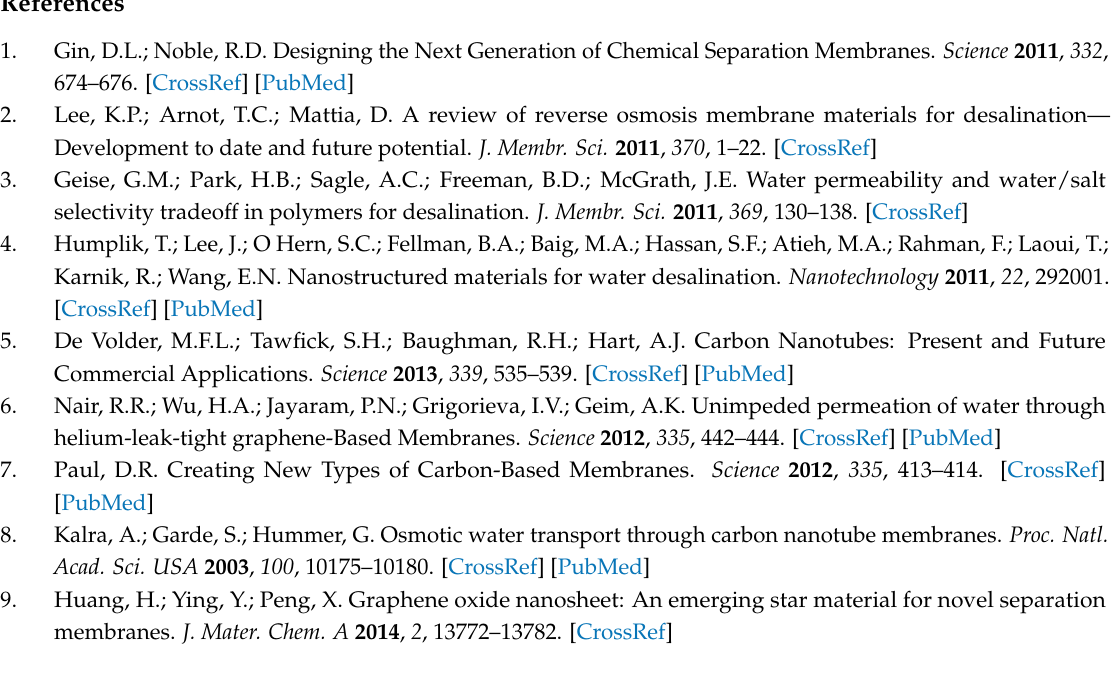
Figure S1: (a) GO membranes obtained from AAO filter, Teflon filter and cellulose nitrate (CN) filter had different stability in water; (b) GO (AAO) membrane remained intact whereas GO (Teflon) membrane; and (c) GO (CN) membrane readily disintegrated in water. Notes that the photos were taken after the solutions had been stirred with a lab spatula, except for the one showing GO (Teflon) and GO (CN) in water for 30 min. Figure S2: The side-view photos complementary to those shown in Figure S1 contrasting to the stability of neat GO membrane and Al 3+ contaminated GO membrane in water. (a) The neat GO membrane (obtained with Teflon or cellulose nitrate filter paper) readily swelled upon soaking in water. After 2 h of soaking, disintegration could already be observed without any agitation. After gentle stirring with a lab spatula for a few seconds, it completely disintegrated and started to redisperse in water. In contrast, (b) the Al 3+ crosslinked GO (AAO) membrane remained stable in water after days of soaking, which clearly demonstrated that GO (AAO) membrane was stable and neat GO membrane readily disintegrated. Figure S3: GO membrane obtained from the AAO filter was contaminated with Al 3+ . (a) Photo showed an 18 µ m thick GO membrane detached from an AAO filter disc. (b) Sets of Al 2 p spectra measured during XPS depth profiling of GO (AAO) from the bottom side and (c) from the top side. (d) Al/C ratio as a function of etching depth from both sides of the GO (AAO). (e) Depth profiling of GO (Teflon) from the bottom side suggested that no Al 3+ was presented. Figure S4: Removal of Al 3+ by ionic exchange. (a) Photos of GO (AAO) membrane soaked in 0.1 M HCl for 3 days (top) and then in water for 30 min (bottom); (b) Ionic exchange with monovalent cations such as Na + and Li + led to the removal of Al 3+ and disintegrated of GO (AAO) membranes in water; (c) XPS Al 2 p spectra of GO (AAO) membrane before and after HCl treatment, suggesting removal of Al 3+ . Note: All the photos were taken after the solutions were stirred with a lab spatula. Figure S5: Strengthening of GO (Teflon) membrane by Al 3+ crosslinking. (a) Photos of GO (Teflon) membrane soaked